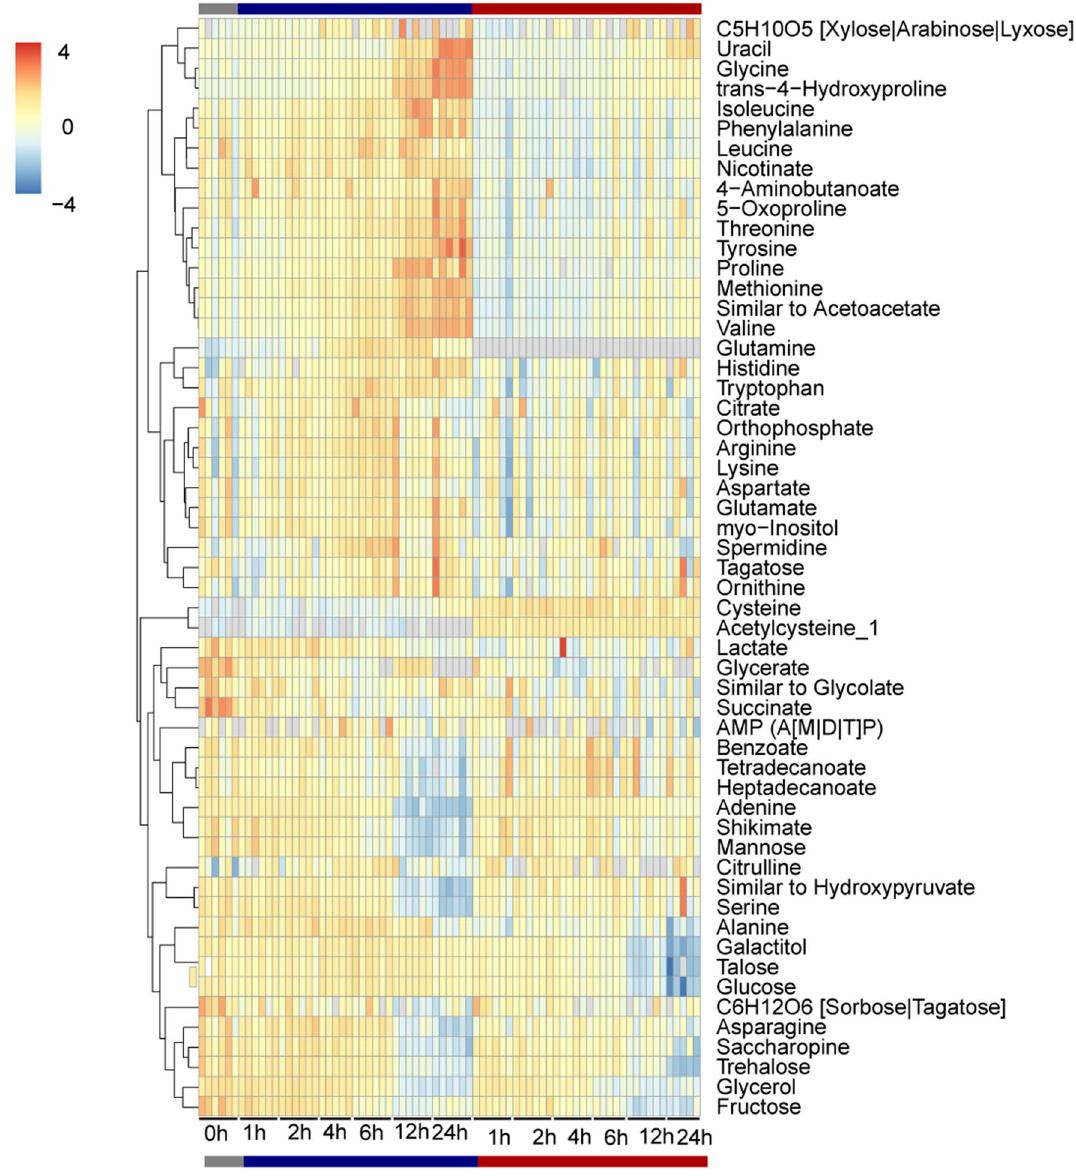
Figure 5. Heat map of metabolic responses to the control or NAC treated cells along 24 h X. citri growth. Metabolite levels were normalized by the mean of all samples from given metabolite and log 2 transformed. Values are means of up to 5 biological replicates. Red and blue colors represent increase and decrease of metabolites, respectively. Samples are arranged according to the treatment. Metabolites are grouped according to the HCA